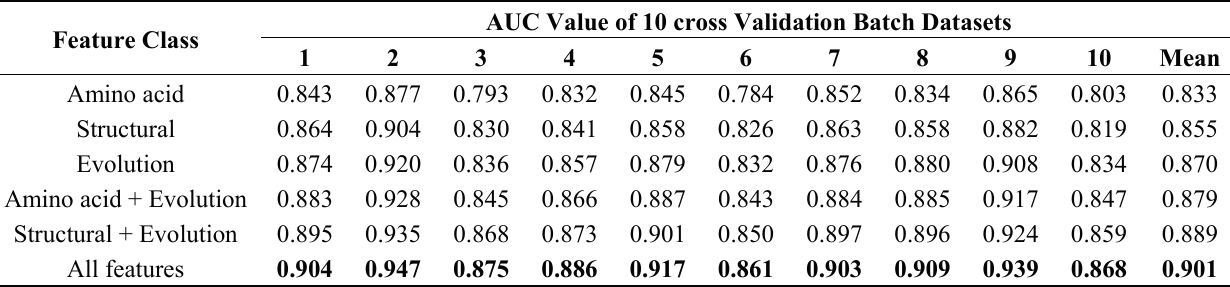
Table 4. Contribution of different combinations of feature classes for the AUC value on 10 cross validation batch datasets of